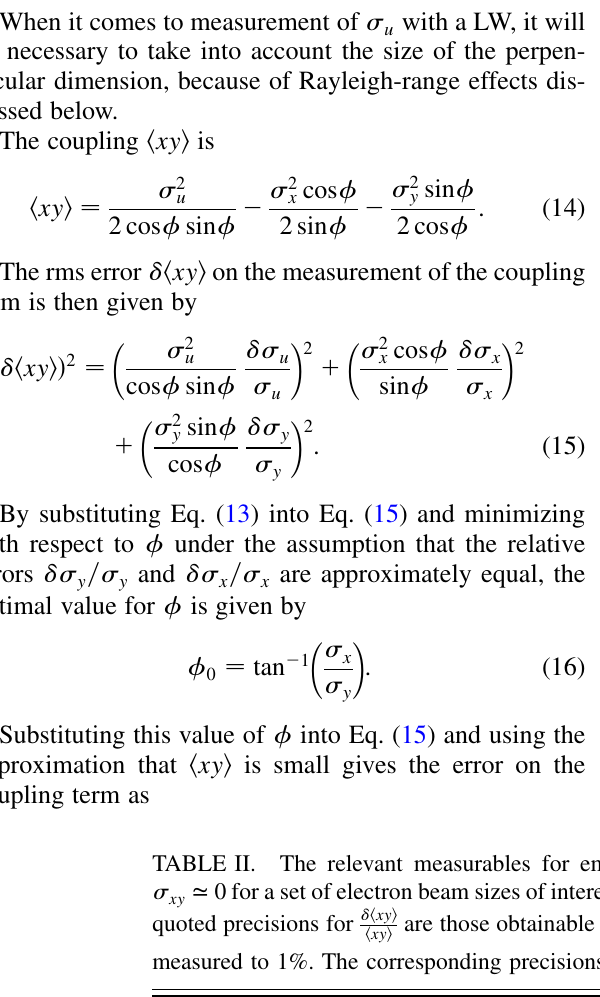
. The b , (cid:2) , and (cid:2) can be x y u and (cid:8)(cid:2) 2 y are then both 2%. (cid:2) 2 x (cid:2) 2 y